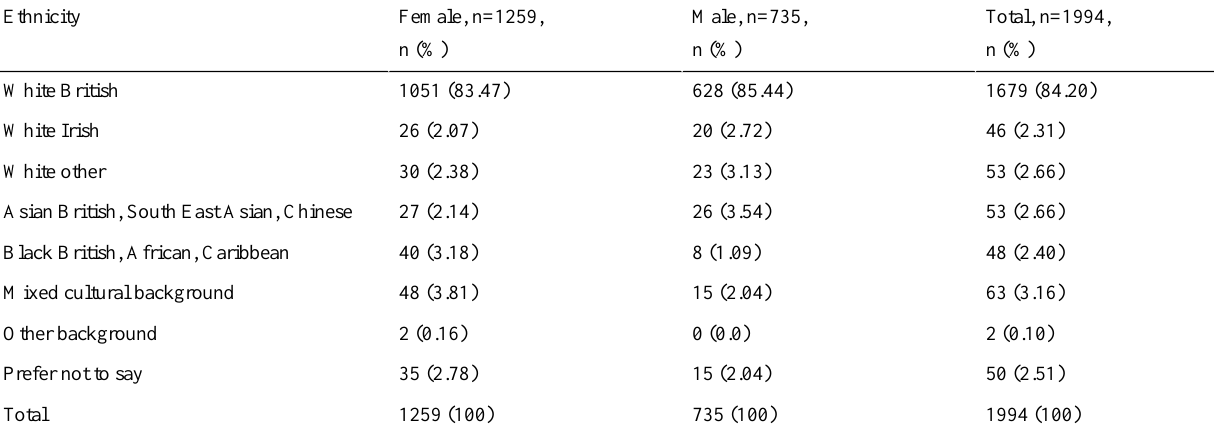
Table 2. Ethnicity (by gender, male or female).